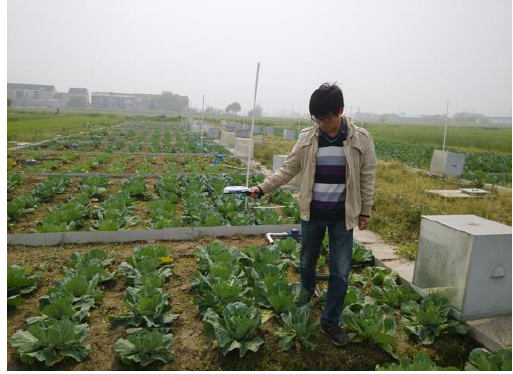
Figure 2. Picture of Greenseeker taking measurements over the canopy of cabbage.